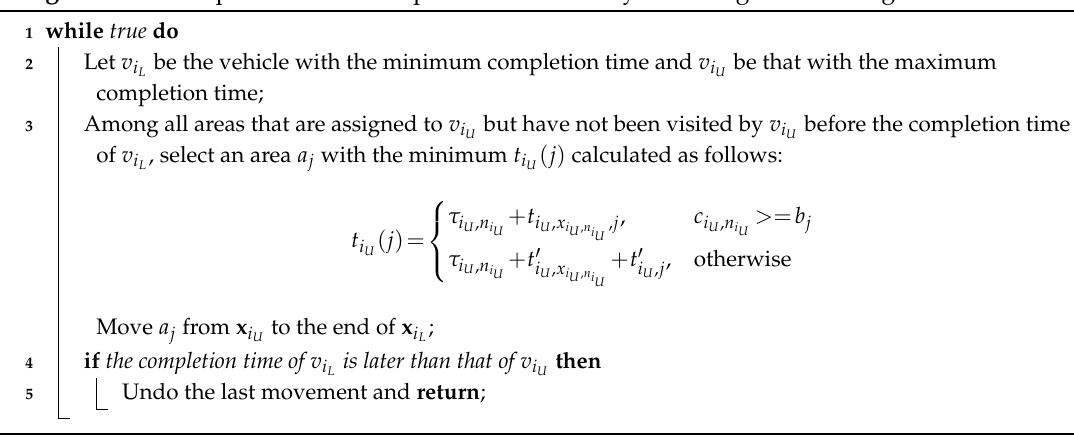
Algorithm 4: The procedure that improves a solution by balancing areas among